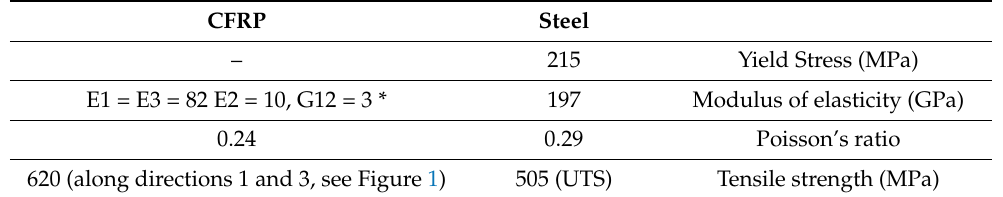
Figure 1. Geometry of the tested SLJs (not to scale). Table 1. Mechanical properties of the adherends [20,22].